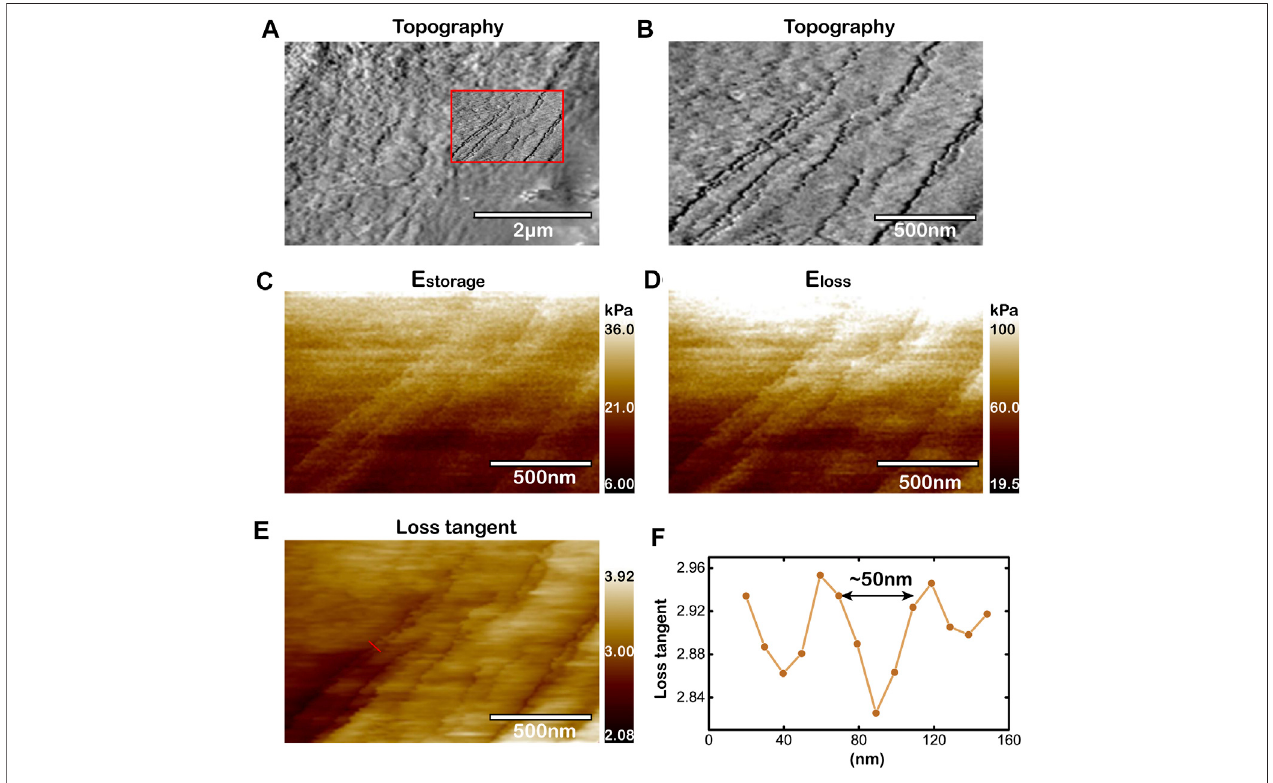
FIGURE3 | Capability toimage cytoskeleton microstructures ofliving cells byimproved AM-FM AFM. (A , B) Topographyof microregion nearthe peripheryof living cancer cell. The view of (B) magni fi es the rectangular region within the red box in (A) . Topography of the red box in (A) . (C – E) Mapping of E storage (C) , E loss (D) , and loss tangent (E) simultaneously obtained by AM-FM AFM. (F) Cross-section pro fi les for the loss tangent along the red solid line in (E) .